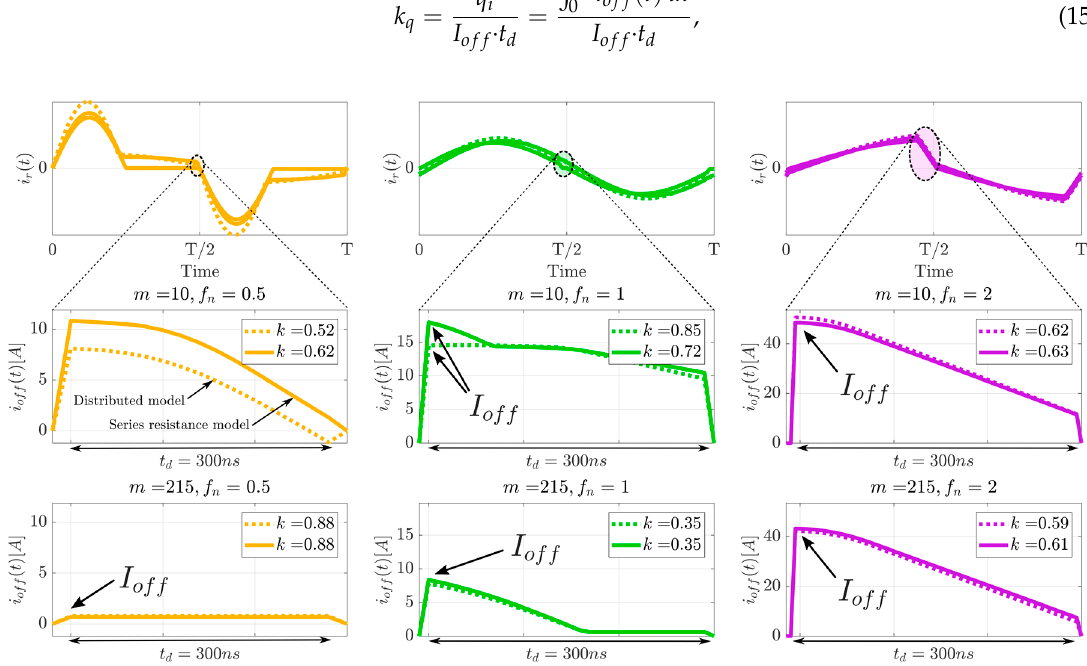
Figure 14. Time-based (TB) simulated currents of each mode and close-up of the dead-time transition for di ff erent LLC converter operation modes.